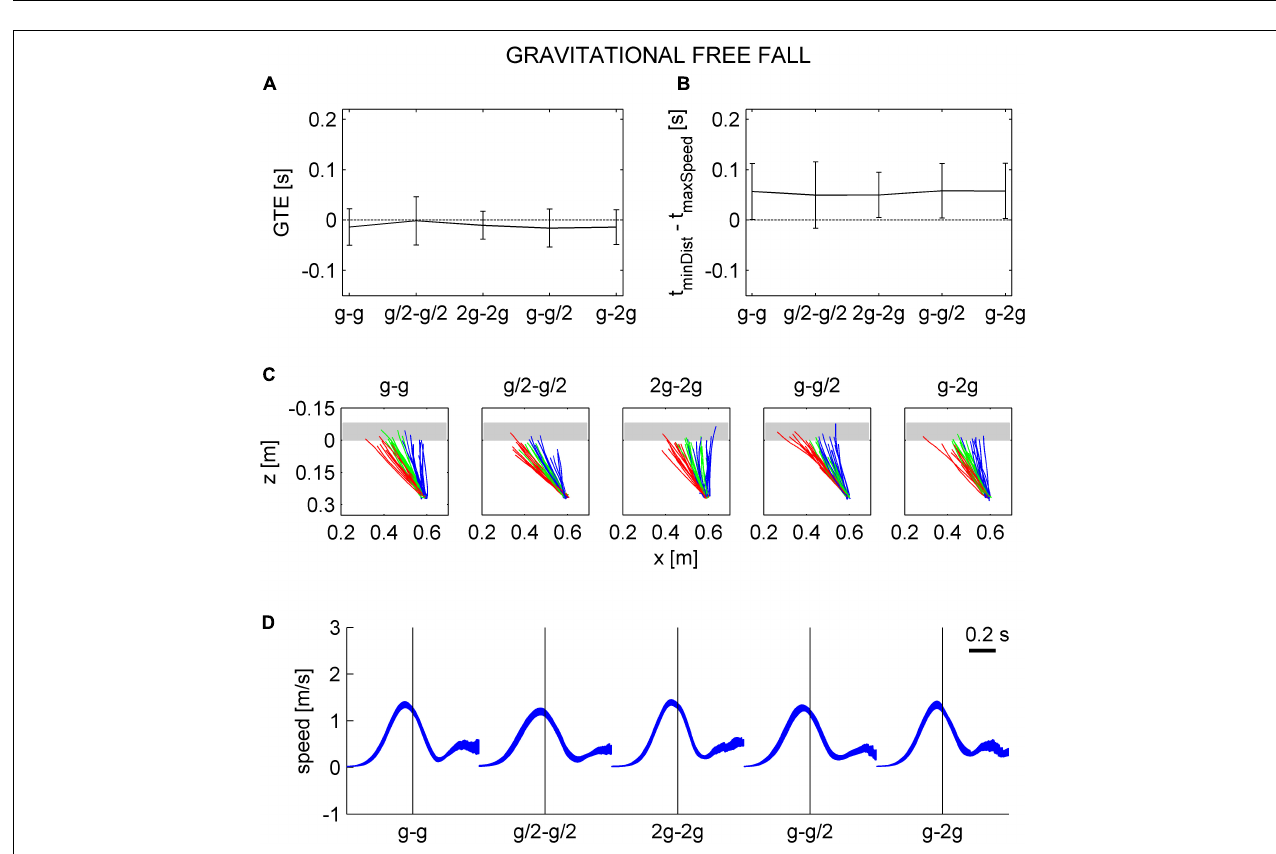
FIGURE 9 | Spatial distributions of endpoint positions. Each panel plots the x – y positions ( n = 192) of the hitter when it crossed, for the first time, the proximal, frontal plane tangent to the ball surface for all trials of all participants in the indicated gravity condition. Curved parallel lines represent the envelope of the path followed by the ball in the frontal